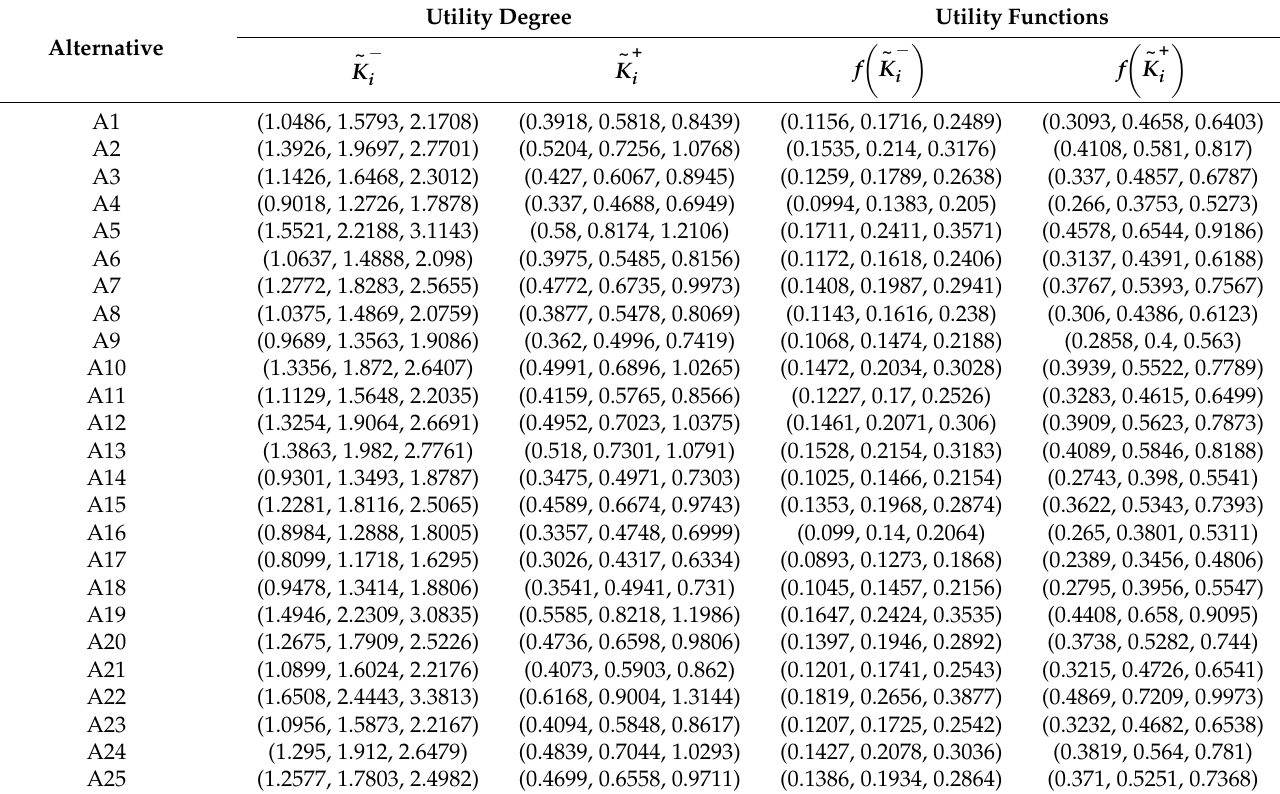
Table 5. Utility degree of alternatives and utility functions (case study